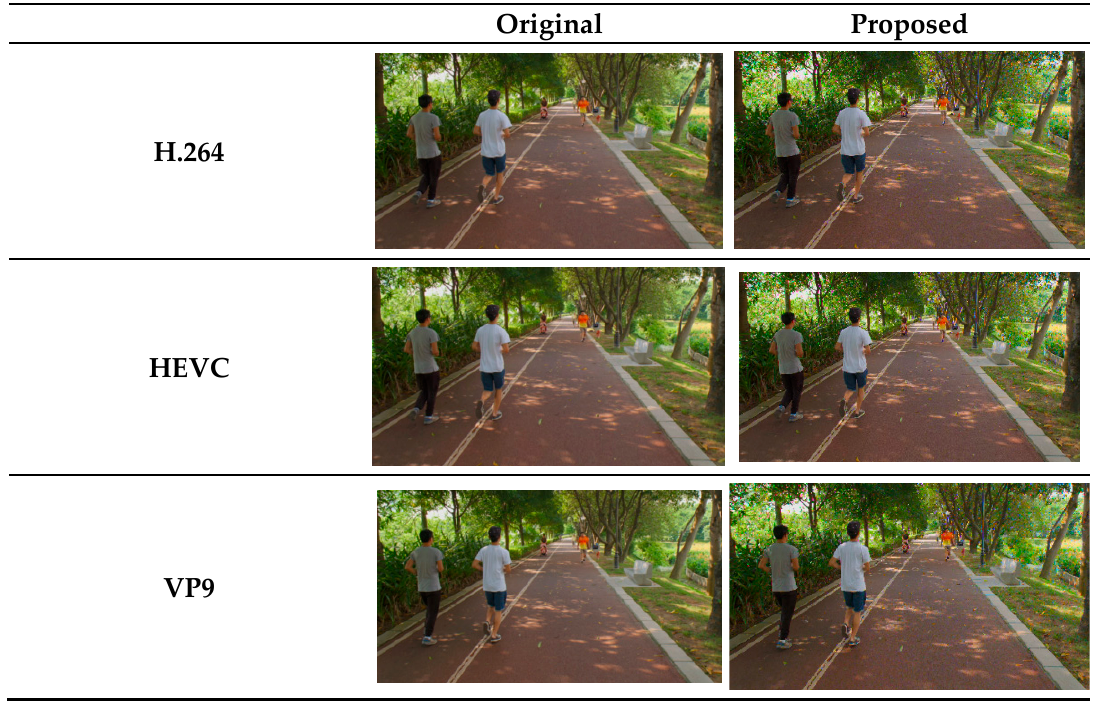
Figure 11. Subjective quality performance for the ‘ParkRunning3’ sequence.